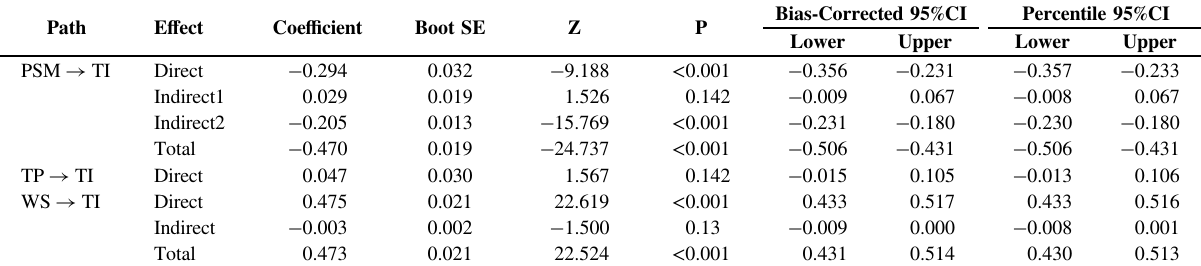
Table 3 Results of the e ff ects on task performance. Path E ff